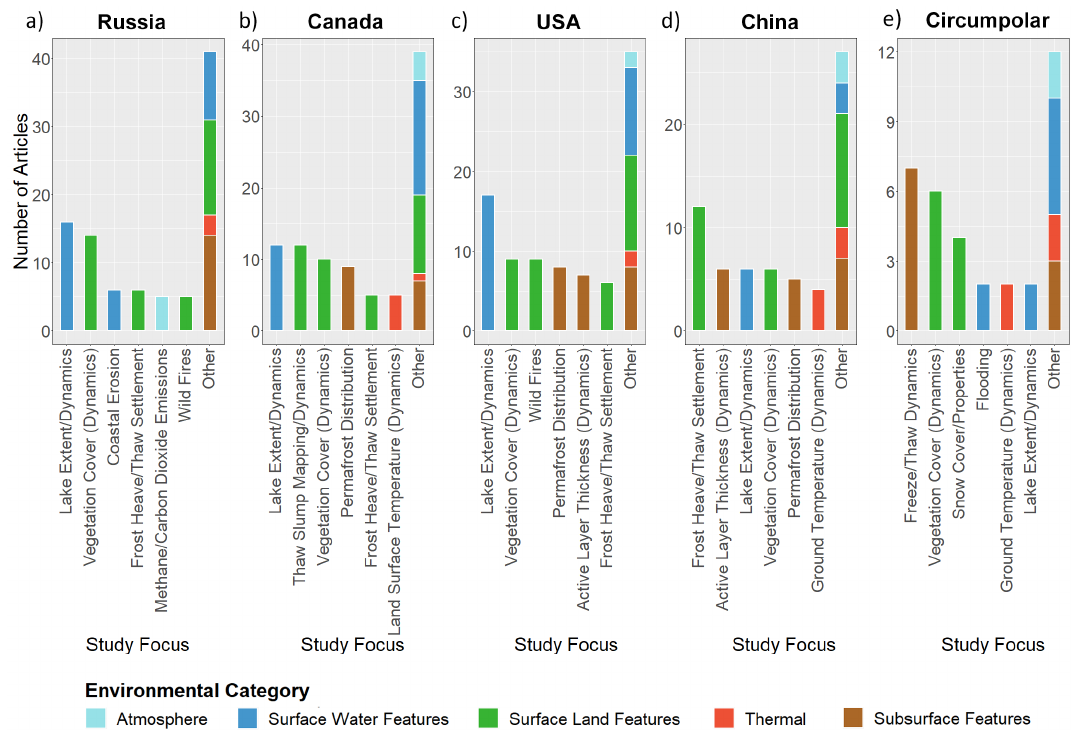
Figure 9. Study focus distribution for the top four most studied countries and circum-Arctic studies. Featured countries are Russia ( a ), Canada ( b ), United States ( c ), China ( d ) and circumpolar studies ( e